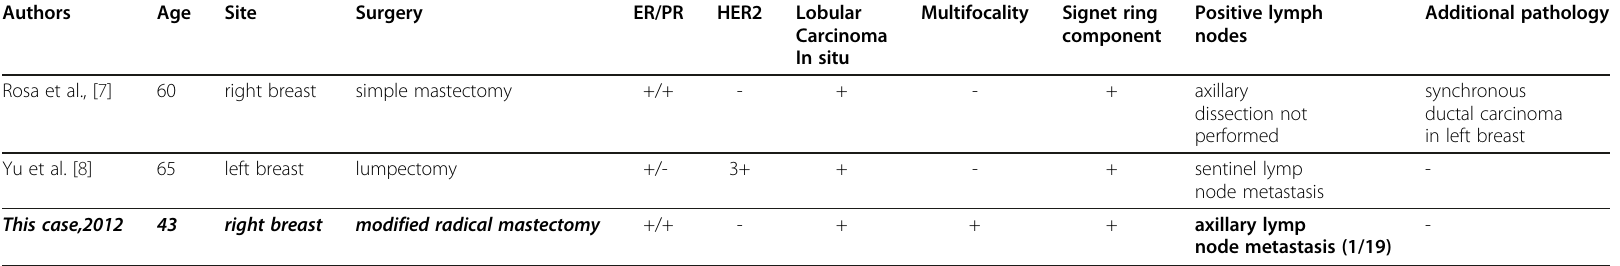
Table 1 Summary of the reported case of lobular carcinoma with intra and extracellular mucin secretion